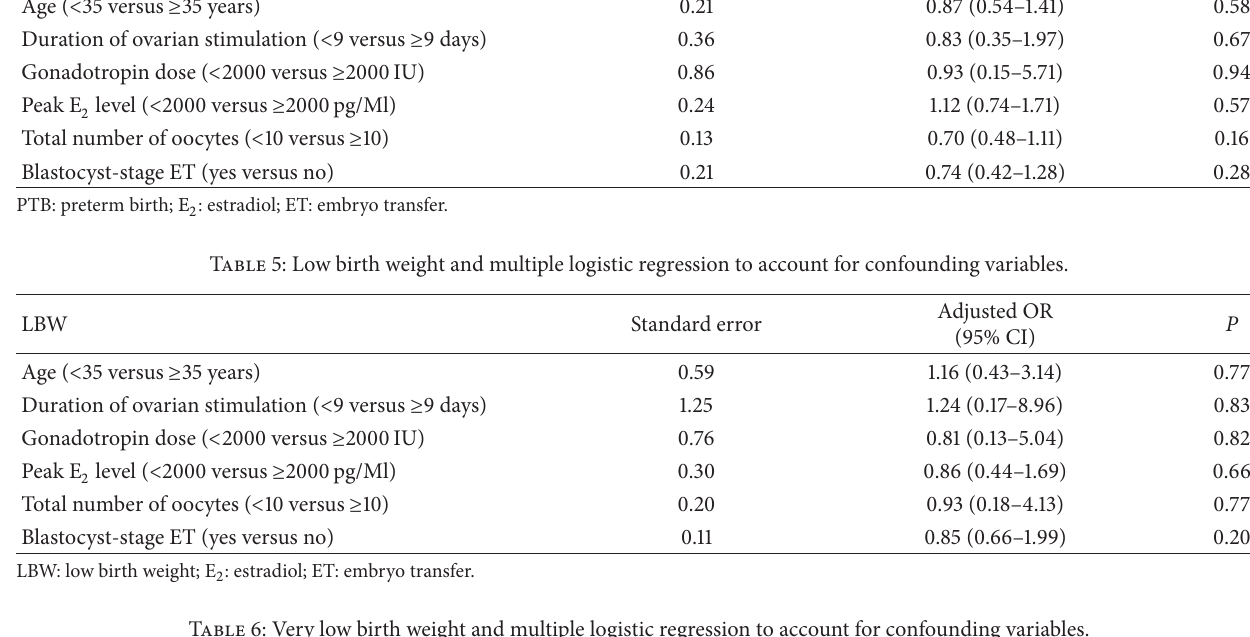
Table 6: Very low birth weight and multiple logistic regression to account for confounding variables.